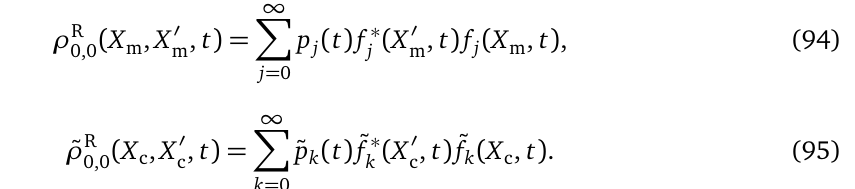
Figure 3: Temporal evolution of von Neumann entropies S ( t ) (circles) for several different values of Ω as designated in the legend. We ˜ S N ;0,0 = 0.2, (cid:34) = 0.1, ω = 1, ¯ ω = 3, and ν ≡ ¯ (cid:34)/(cid:34) = used g 0 m,0 c,0